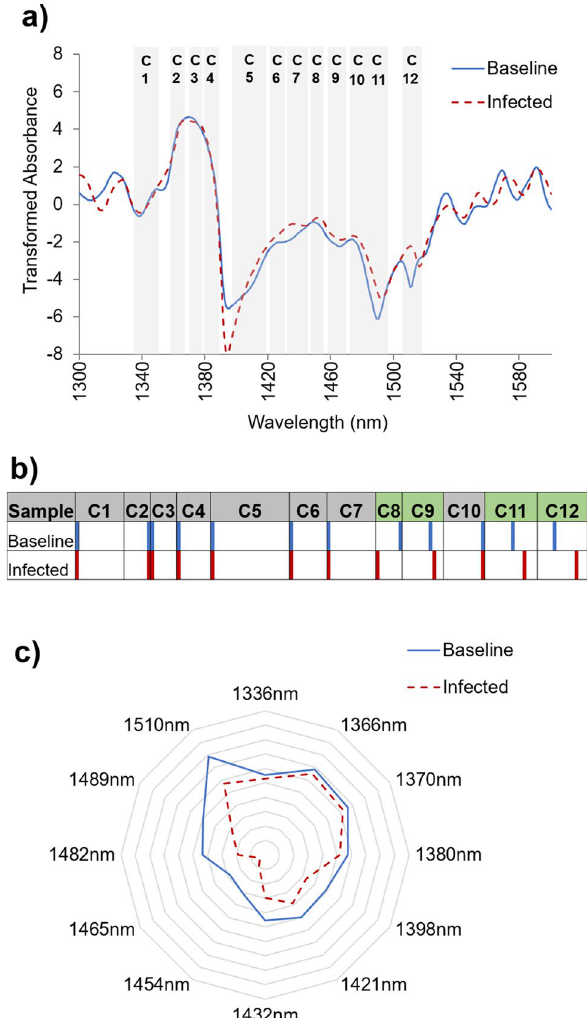
Figure 4. Aquaphotomics. ( a ) Transformed NIR spectra corresponding to bovine plasma collected before and after the M. haemolytica challenge . The spectral information from sterile distilled water was removed from the average spectra. ( b ) Peak shifts can be observed in the WAMACS barcode in the coordinates C8, C9, C11, and C12 for the baseline and infected blood plasma. ( c ) Aquagram displaying the normalized averaged spectra (SNV only) showing different WASPs. The highest points of absorbance were found at 1366 and 1510 nm for the Infected and Baseline plasma,